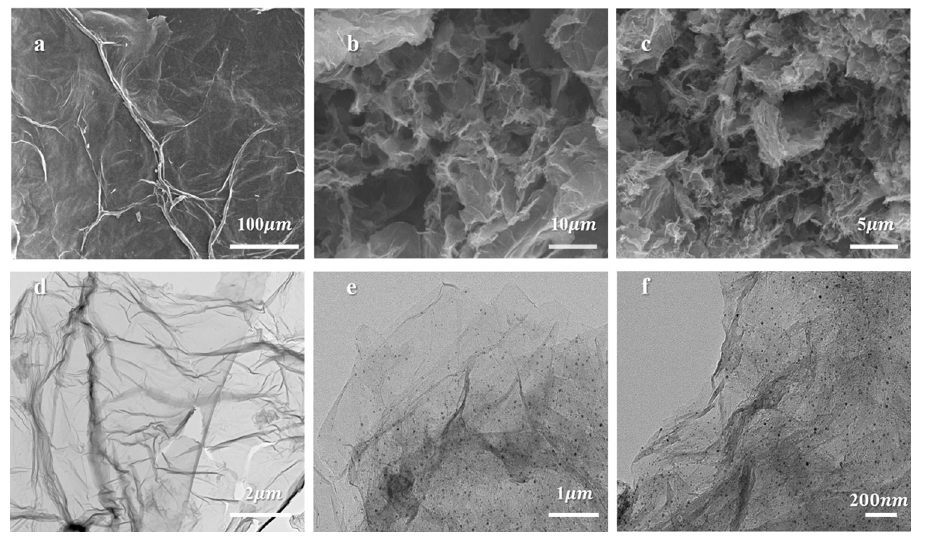
Figure 1: SEM and TEM results: ( a ) SEM image of GO, ( b and c ) SEM images of 3DGNs, ( d ) TEM image of 3DGNs, ( e and f ) TEM images of 1.0 Pd/3DGN catalyst.